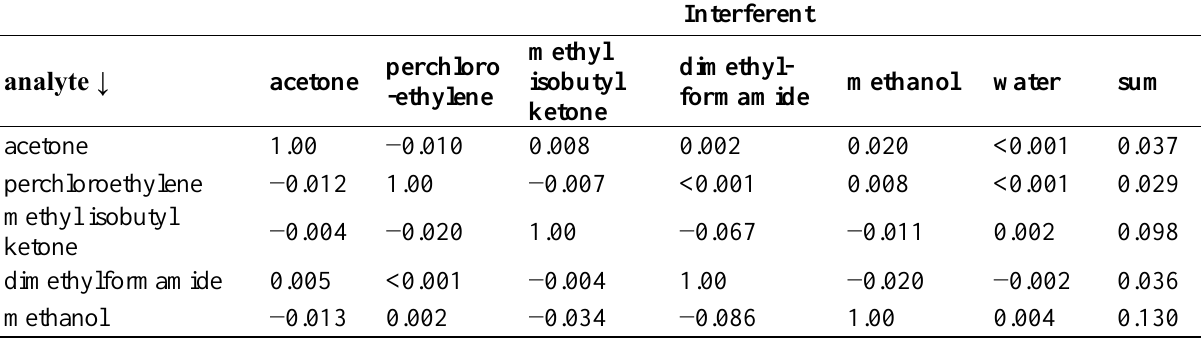
Table 6. Cross selectivity‟s of the five VOCs and water in [ppm∙ppm −1 ]. For example, when measuring acetone and perchloroethylene‟s concentration increases by 100 ppm, the measured acetone value will decrease by 1 ppm.